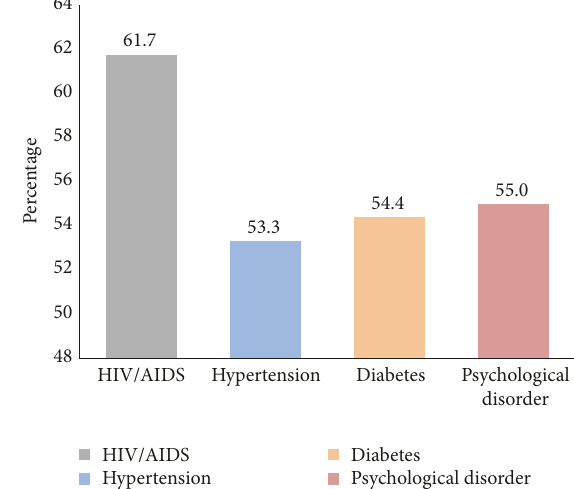
Figure 1: Proportion of patients with chronic diseases who are noncompliant to their medication